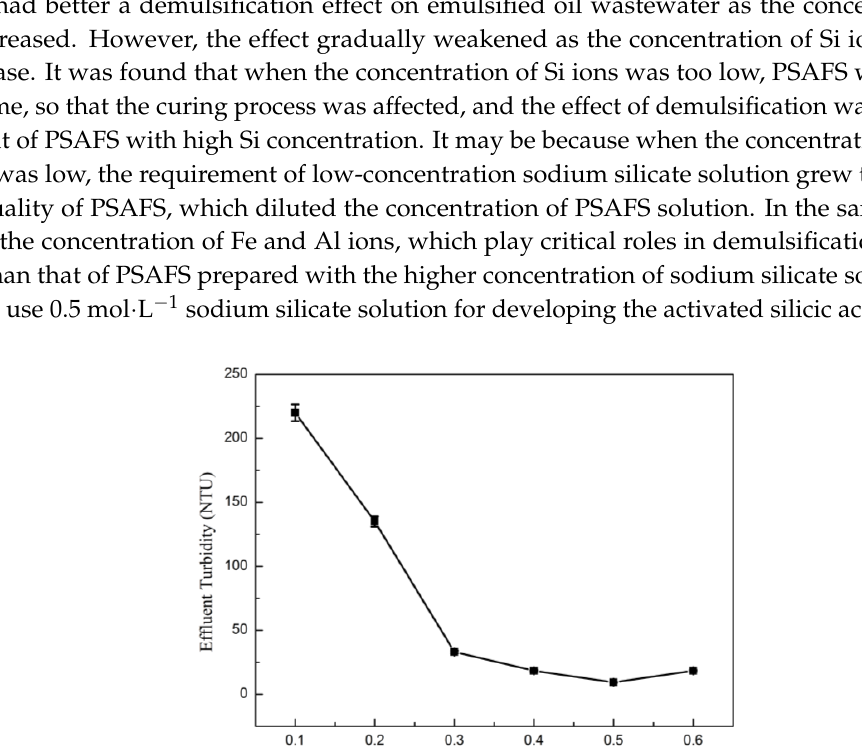
Figure 3. Influence of sodium silicate concentration on oil-removal ability of PSAFS.